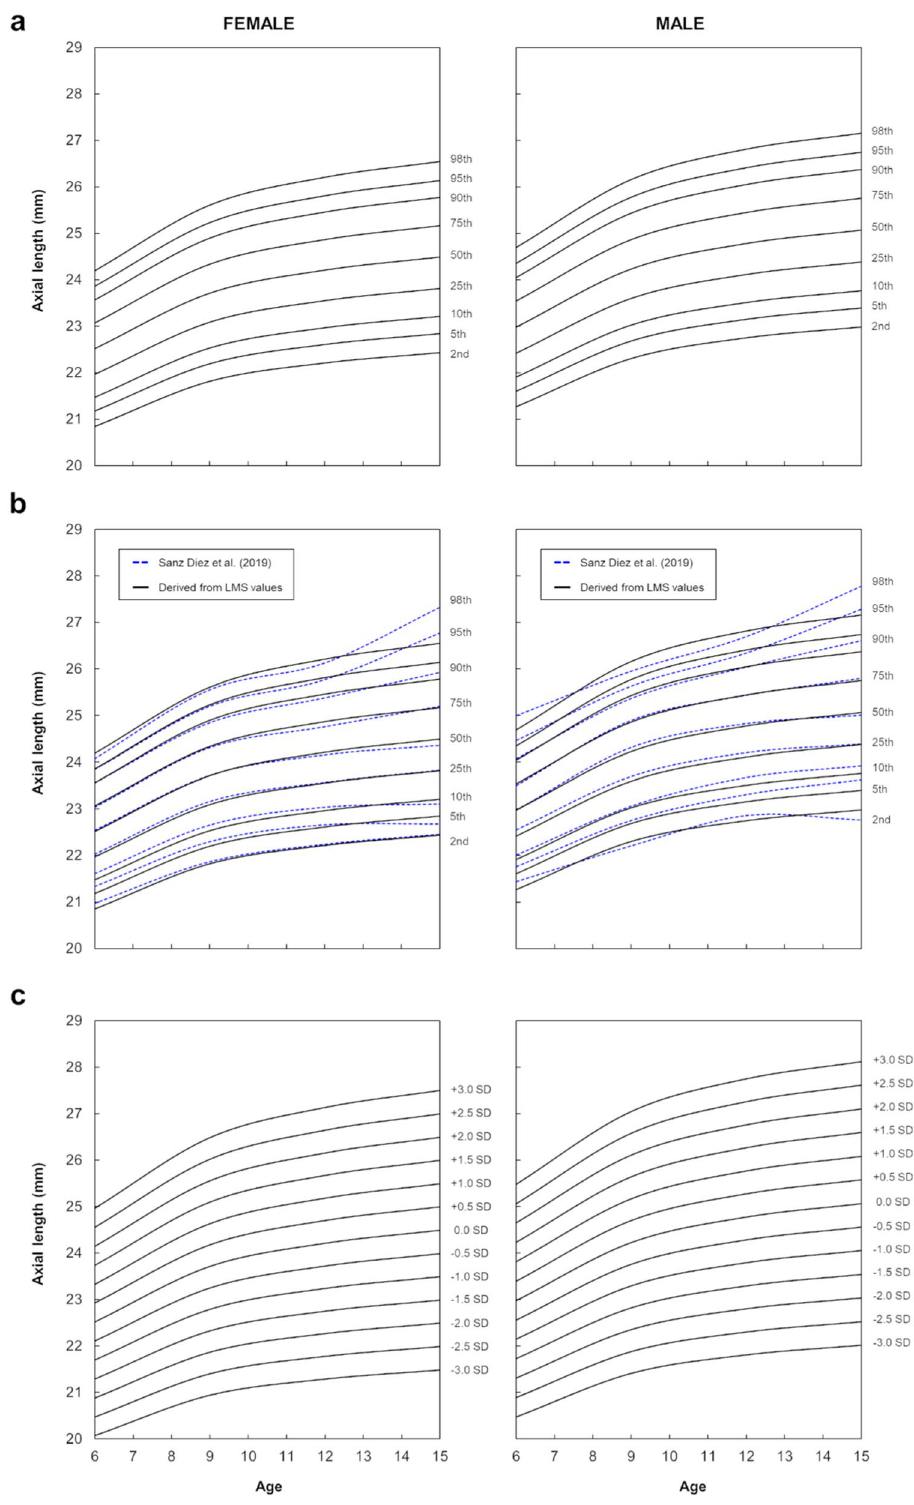
Figure 1. Growth curves of axial length derived from the LMS values. Female group (left) and male group (right). ( a ) Percentile curves of axial length derived from the LMS values. Nine percentile curves are displayed: 2nd, 5th, 10th, 25th, 50th, 75th, 90th, 95th and 98th. ( b ) Comparison of the axial length percentile growth curves as originally published by Sanz Diez et al. 10 (blue dashed line) with those derived from the LMS values (black solid line). ( c ) Z-score growth curves of axial length derived from the LMS values. Z-scores range from − 3 to + 3 in 0.5 SD